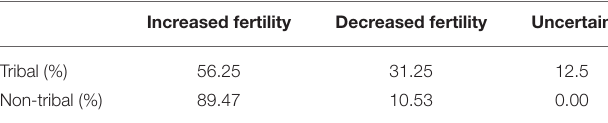
TABLE 8 | Farmer assessment of the impact of legumes on soil fertility. Increased fertility Decreased